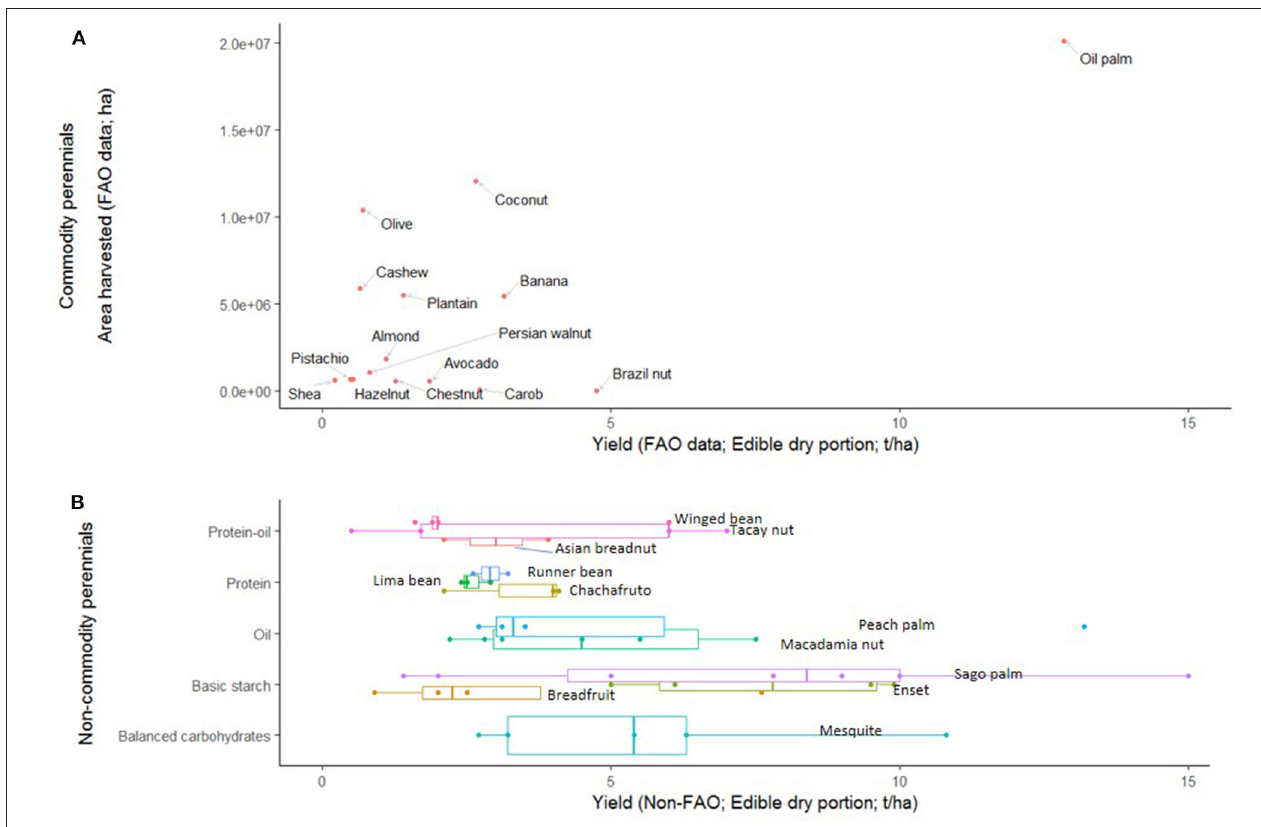
FIGURE 3 | Yields and areas harvested. (A) Perennial staple commodity crops with both yield and area harvested data from the UN FAO. Yields and area harvested are not significantly correlated if oil palm is removed from the data ( P = 0.94). (B) Top-yielding perennial staple crops ( > 2.5 t/ha on average) that do not have FAO production data, plotted on the same scale.